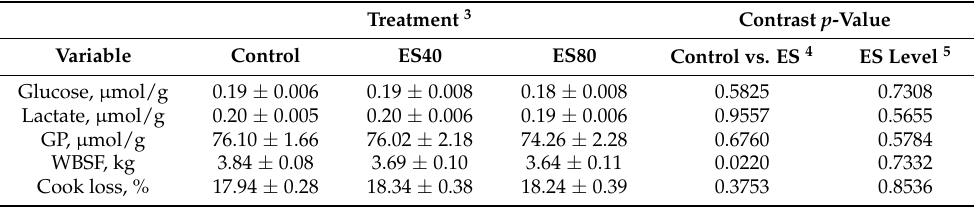
Table 2. Warner–Bratzler shear force (WBSF), cook loss, glucose, lactate, and glycolytic potential (GP) of beef carcasses subjected to low-voltage electrical stimulation for 60 s in 4 s on, 2 s off intervals prior to chilling